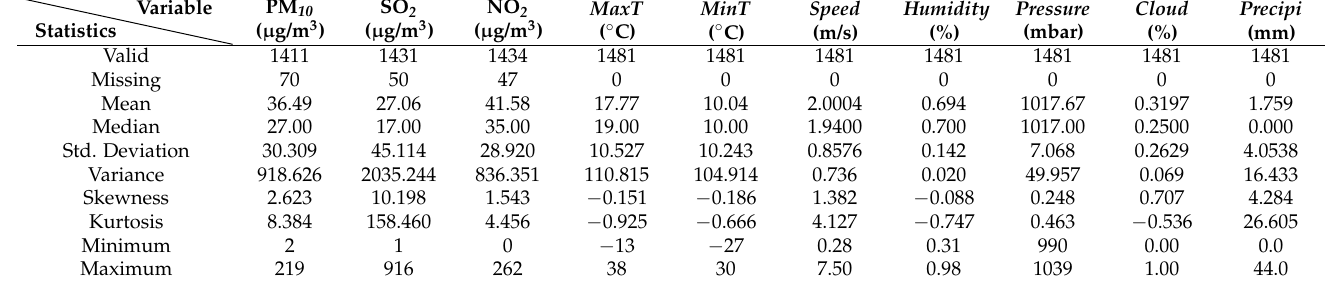
Table 2. Summary statistics of the initial data for pollutants and meteorological variables.